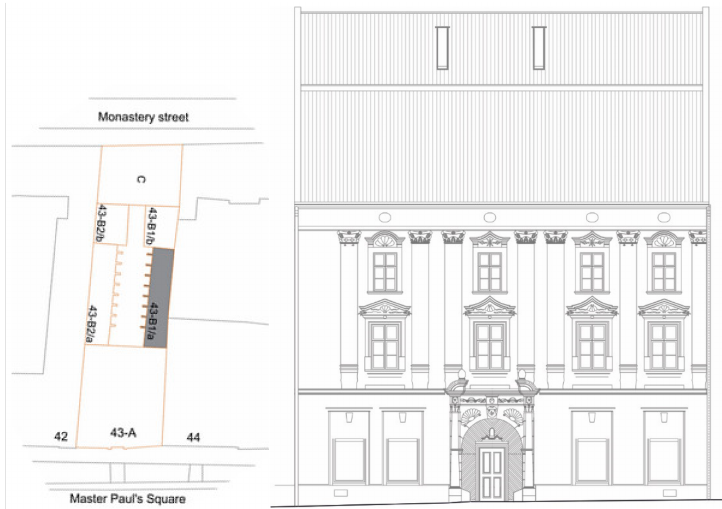
Figure 2. Division of the analyzed building no. 43 into various segments ( left ), contemporary decoration of the main facade—view from Master Paul ´ s Square ( right ) [36].